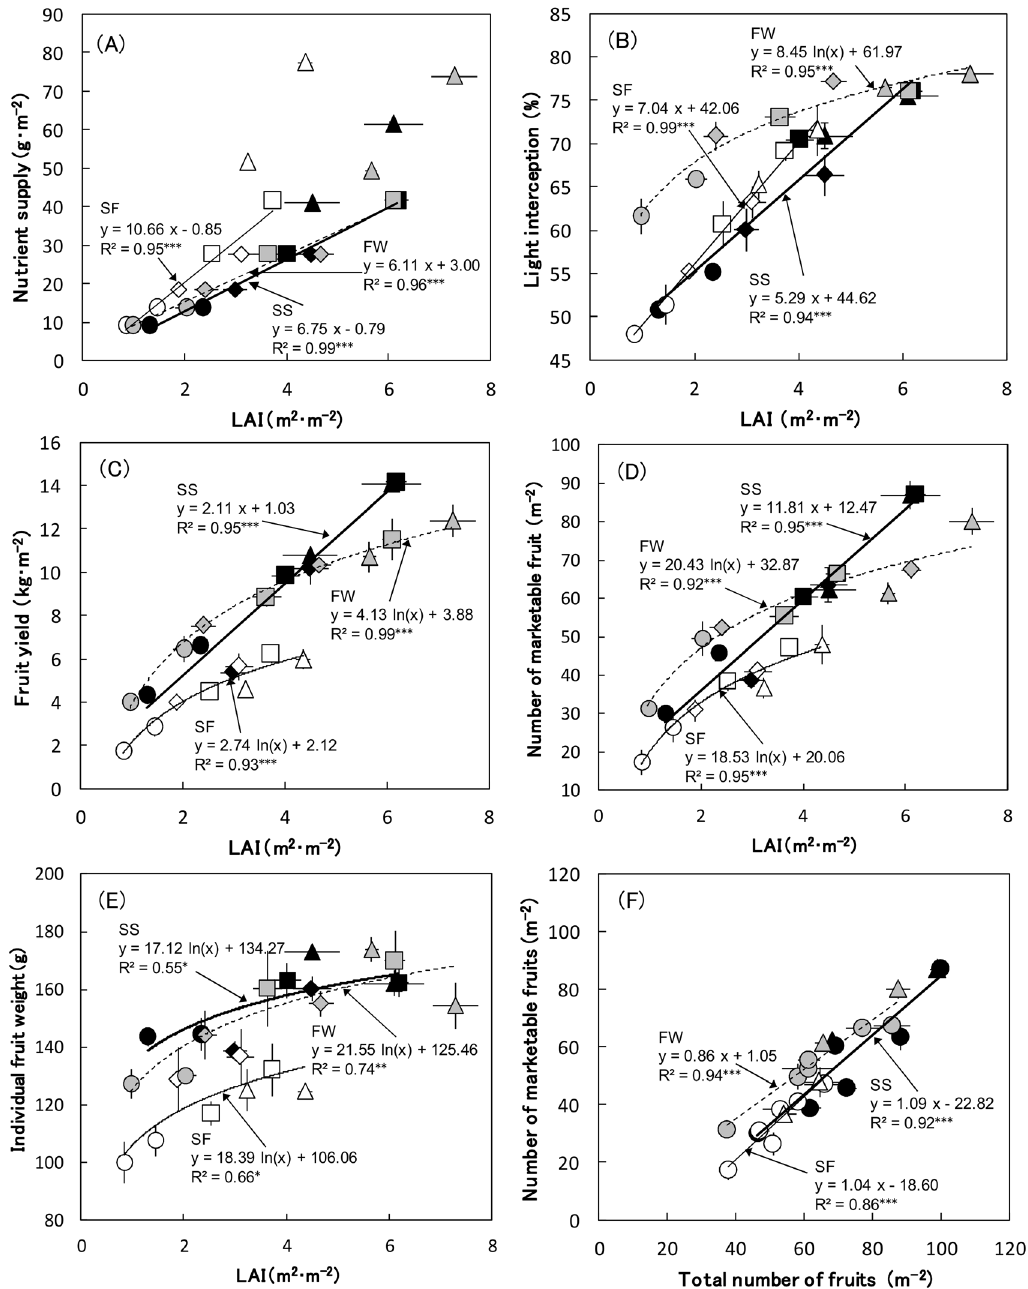
Figure 5. The relationship between leaf area index (LAI) and the various agronomic traits. The total amount of the nutrient supply (N equivalent) (A), light interception by plants (B), marketable fruit yield (C), number of marketable fruit (D), individual fruit weight (E), and the relationship between the total number of fruits and the number of marketable fruits (F). Symbols and regression lines represent the following: (1) Fertilizers, LF: triangle; CRF-L: circle; CRF-M: diamond; CRF-H: square; (2) Cropping seasons, SS: filled; SF: open; FW: gray; (3) regression lines, SS: thick; SF: thin; FW: dotted. Vertical and horizontal bars represent standard errors of the means (n=3). * P , 0.05; ** P , 0.01; *** P , 0.001.